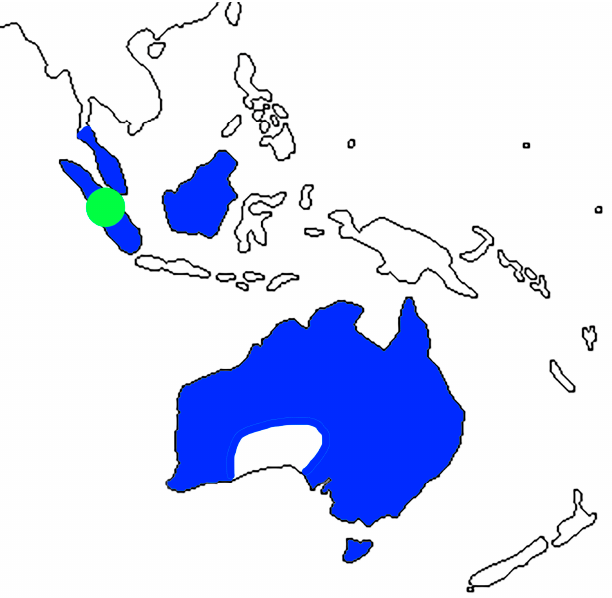
Figure 8. Distribution of Platytarsulini. Fossil record: green sphere—Sumatran amber.